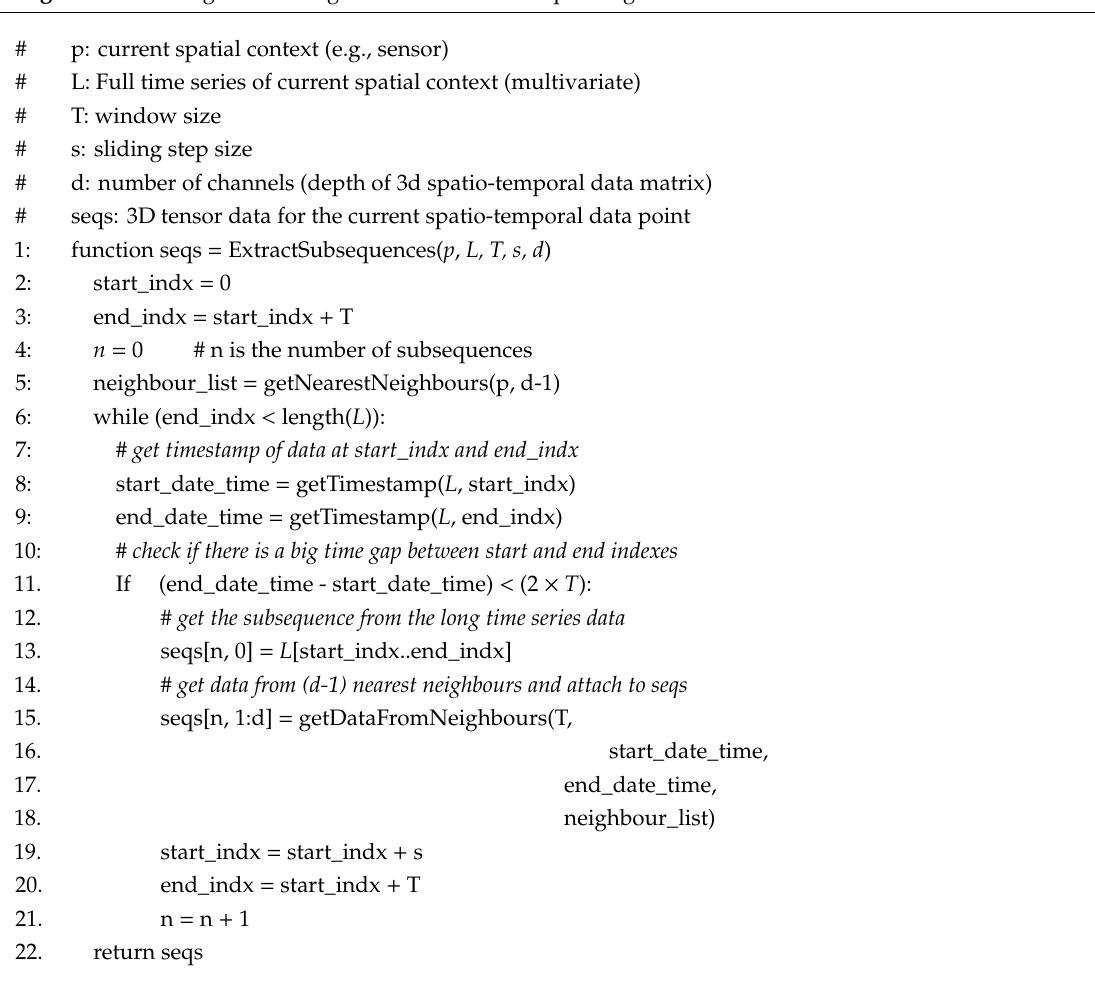
Algorithm 1 Sliding window algorithm used in subsequence